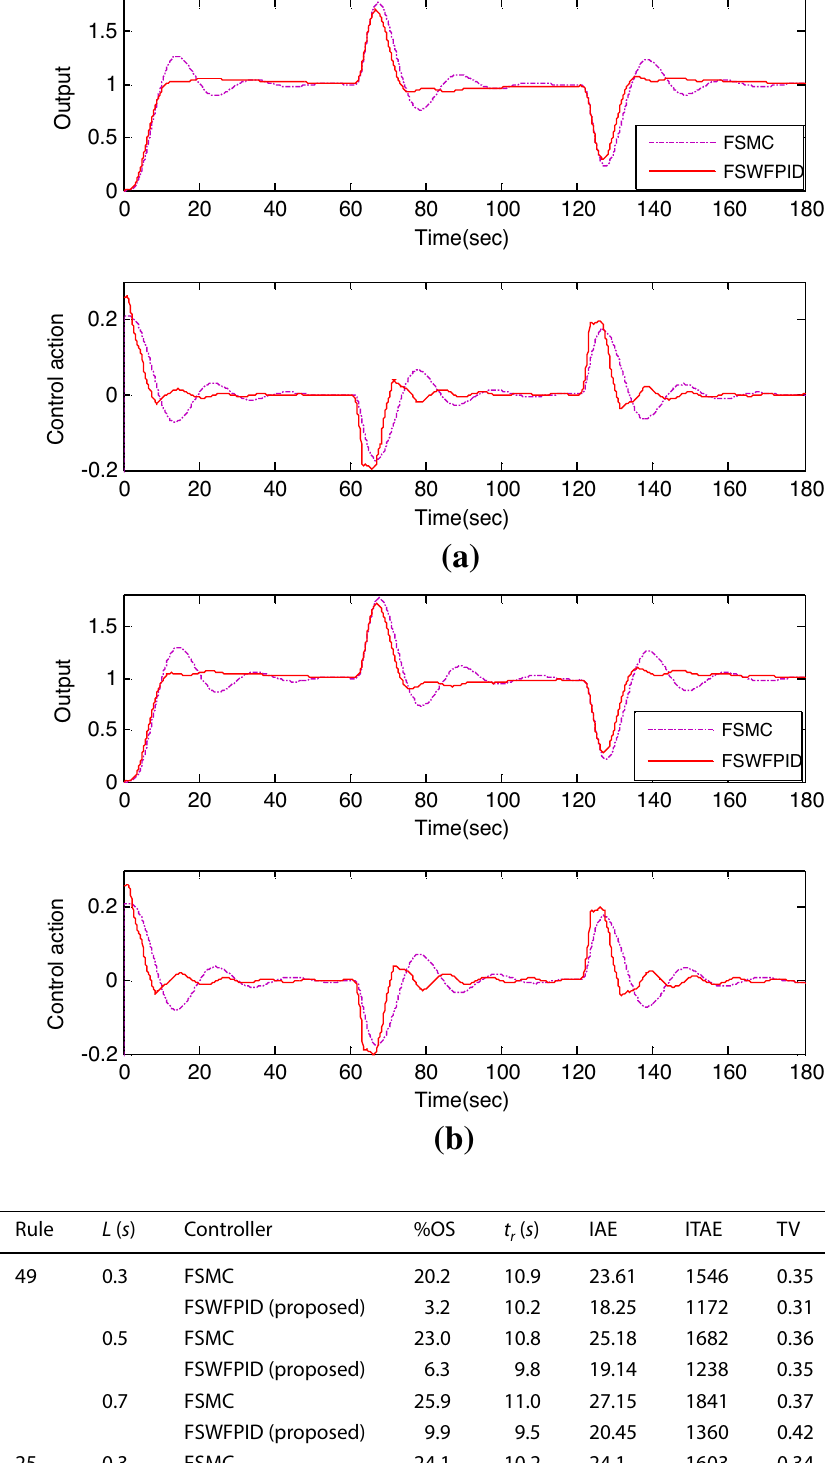
Fig. 15 Comparison among responses and control actions for Model III with FSMC using 25 rules during set point response and with load varia- tion for a L = 0.3 s, b L = 0.05 s